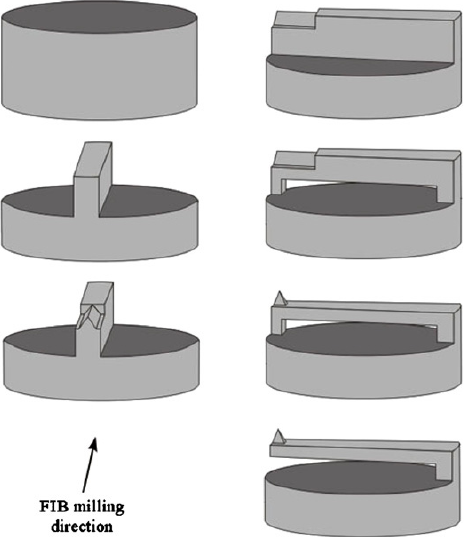
Figure 3. The fabrication process of a fiber ‐ top microcantilever using FIB milling [44].